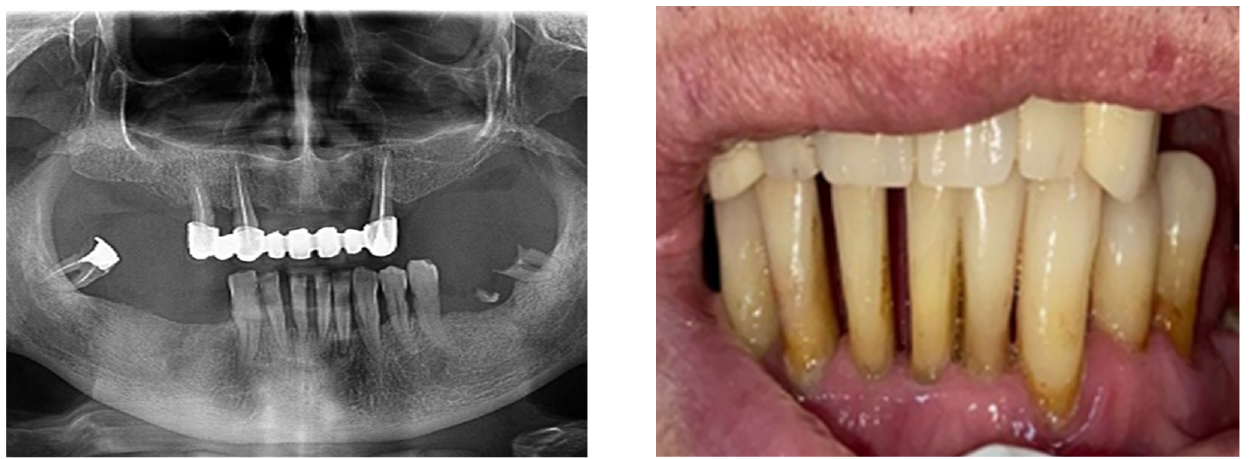
Figure 4. Clinical and paraclinical aspects of dental mobility. ( a ) Paraclinical aspects of dental mobility; ( b ) Clinical aspects of dental mobility.